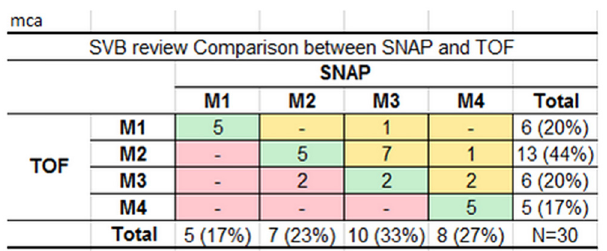
Fig 4. Cross-tabulation of MCA smallest visible branch (SVB) review results by SNAP and TOF MRA. Rows show the number of arteries with the corresponding SVB by TOF and columns show the number of arteries with the corresponding SVB by SNAP. A dash indicates that no arteries had that pair of results. The diagonal shows the number of arteries with the same SVB on both SNAP and TOF (green), while the cells above (yellow) or below (red) the diagonal show the number of arteries where SNAP or TOF was better than the other, respectively. SNAP visualizes more distal branches than TOF in 11 arteries, less in 2 arteries and performs equally in the remaining 17 arteries.